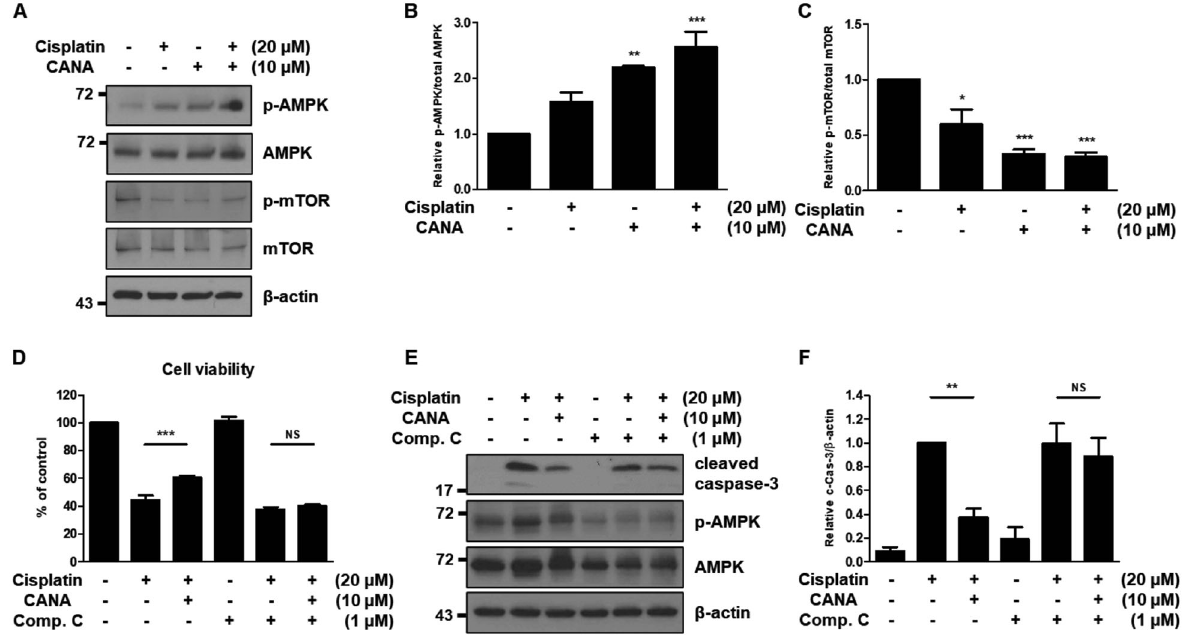
Fig. 3 Canagli fl ozin activates AMPK and inhibits mTOR in HK-2 cells and protects HK-2 cells from cisplatin in an AMPK activation- dependent manner. HK-2 cells were treated with indicated concentrations of cisplatin and/or canagli fl ozin (CANA) for 24 h ( A – C ). A Representative immunoblot analysis. B , C Densitometric analysis of immunoblots to estimate the relative abundance of indicated molecules as normalized that of total AMPK or total mTOR, respectively. Data are expressed as mean ± SD ( N = 4). Differences between groups were evaluated one-way ANOVA followed by Bonferroni ’ s multiple comparison test. * P < 0.05, ** P < 0.01, *** P < 0.001, signi fi cantly different from the control. HK-2 cells were treated with indicated concentrations of cisplatin, canagli fl ozin, and/or compound C (Comp. C) for 24 h ( D – F ). D Cell viability was evaluated by CCK-8 assay. Data are expressed as mean ± SD (N = 5). Differences between groups were evaluated using one-way ANOVA followed by Bonferroni ’ s multiple comparison test. *** P < 0.001. NS, not signi fi cant. E Representative immunoblot analysis. F Densitometric analysis of immunoblots to estimate the relative abundance of cleaved caspase-3 as normalized that of β -actin. Data are expressed as mean ± SD ( N = 5). Differences between groups were evaluated using one-way ANOVA followed by Bonferroni ’ s multiple comparison test. ** P < 0.01. NS, not signi fi